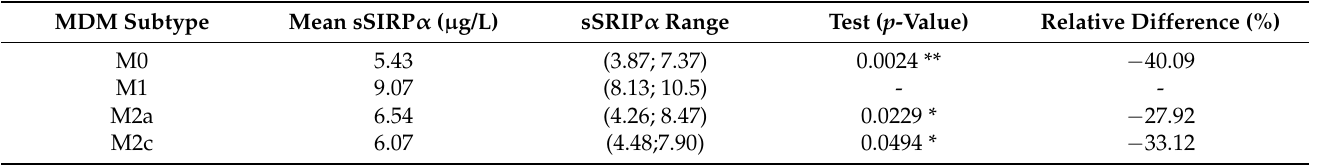
Table 2. sSIRP α